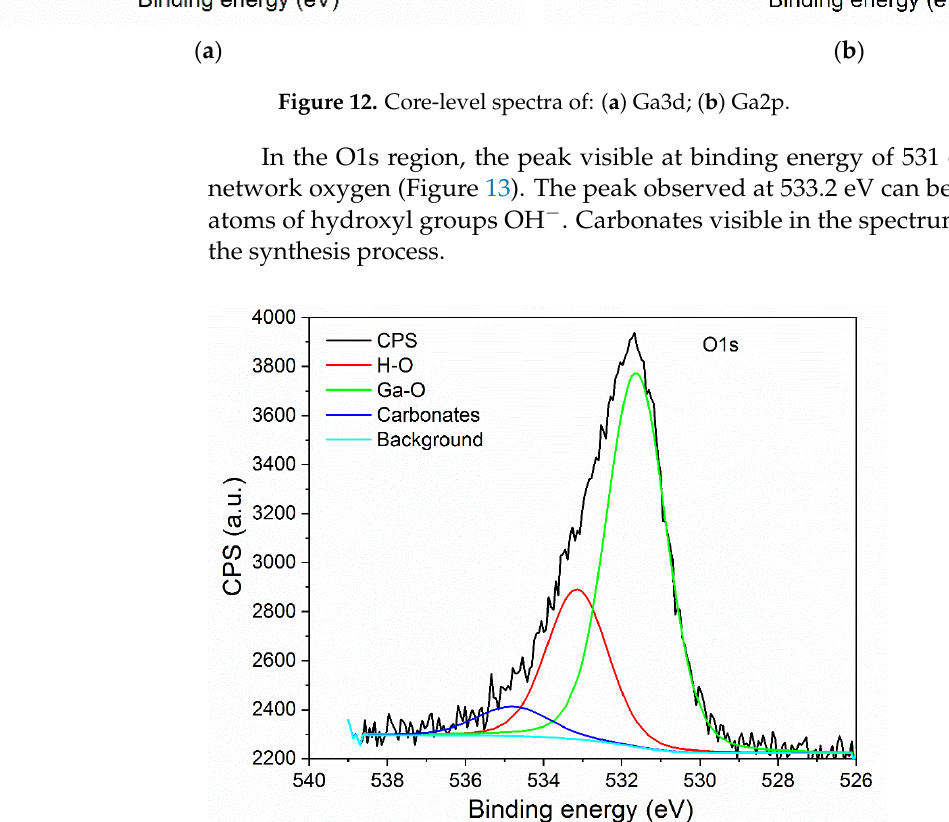
Figure 13. Core-level spectra of O1s region.